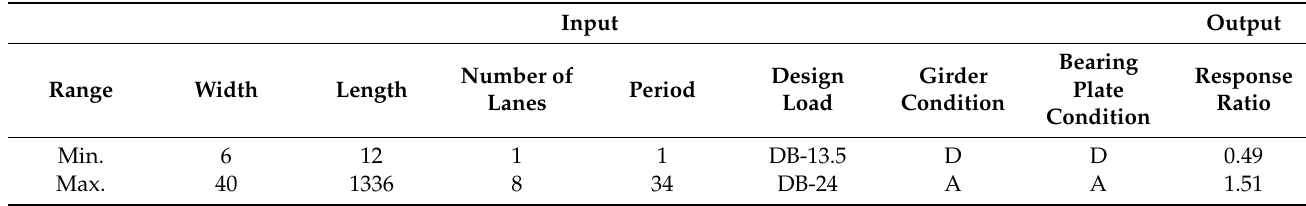
Table 5. Statical properties of bridge information from safety-diagnosis